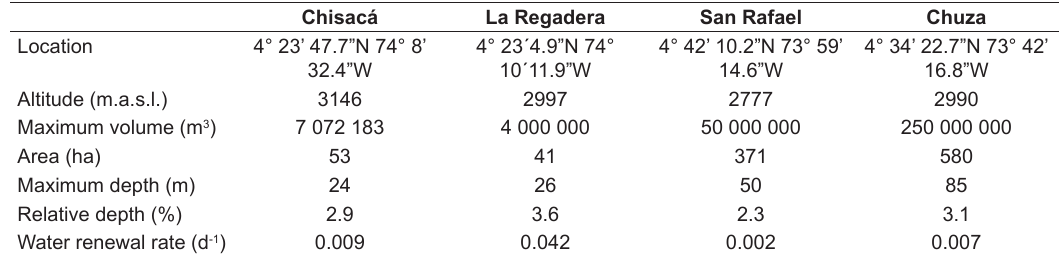
Figure 1. Location of the reservoirs studied in Colombia. Details of the location of the studied reservoirs were described by León et al. (2012). Table 1. Summary of geographic and morphometric data of the four studied